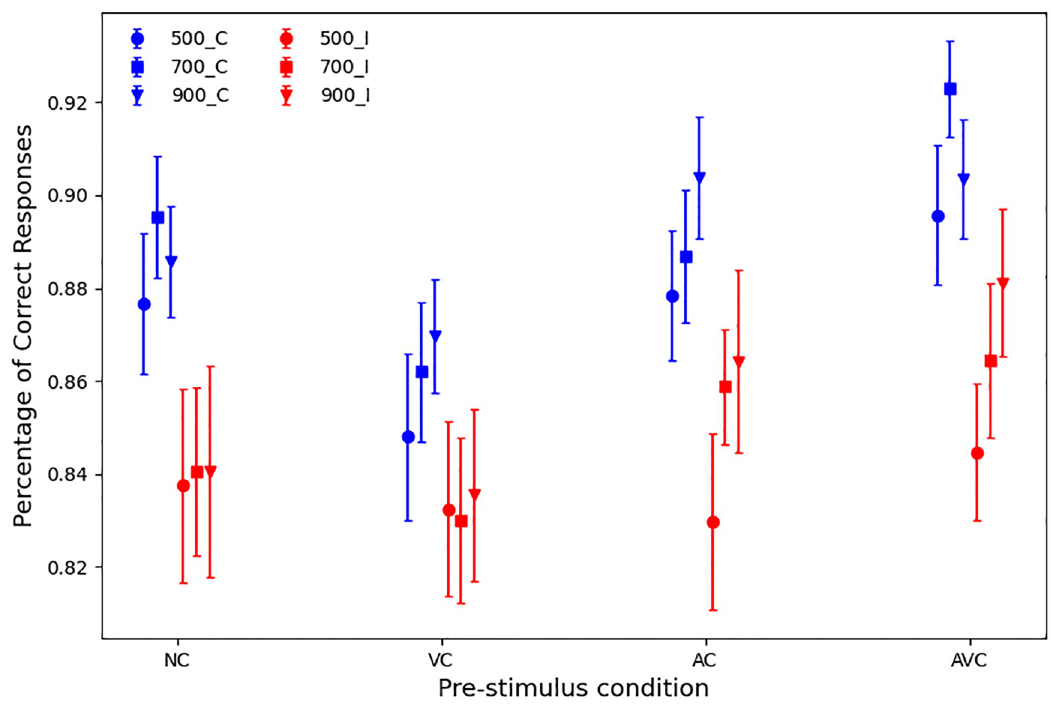
Fig 7. Mean accuracy with standard errors in congruent trials (blue) and incongruent trials (red), according to pre-stimulus display and SOA.